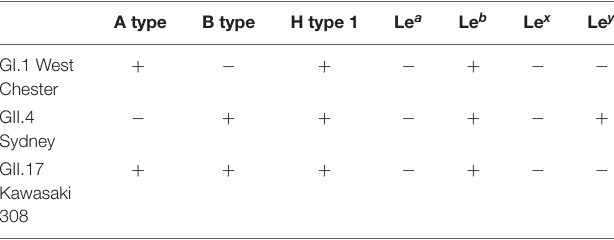
TABLE 1 | Summary of the HBGA binding preferences combined from saliva and synthetic HBGA